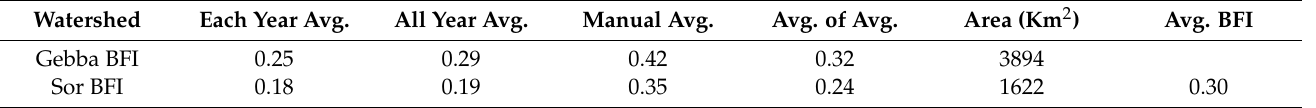
Table 4. Sor and Gebba average values of BFI from FDC and manual